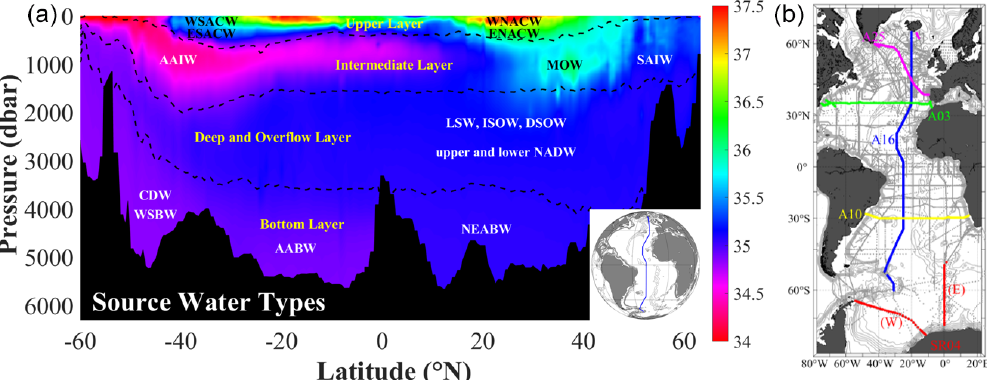
Figure 4. (a) Distributions of water masses in the Atlantic Ocean based on the A16 section in 2013. The background colour shows the absolute salinity (gkg − 1 ). The dashed lines show the boundary of the four vertical layers divided by neutral density. (b) Five selected WOCE/GO-SHIP sections that were selected in this work to represent the vertical distribution of the main water masses. Table 2. Summary of the criteria used to select the water samples considered to represent the source water types discerned in this study. For convenience, they are grouped into four depth